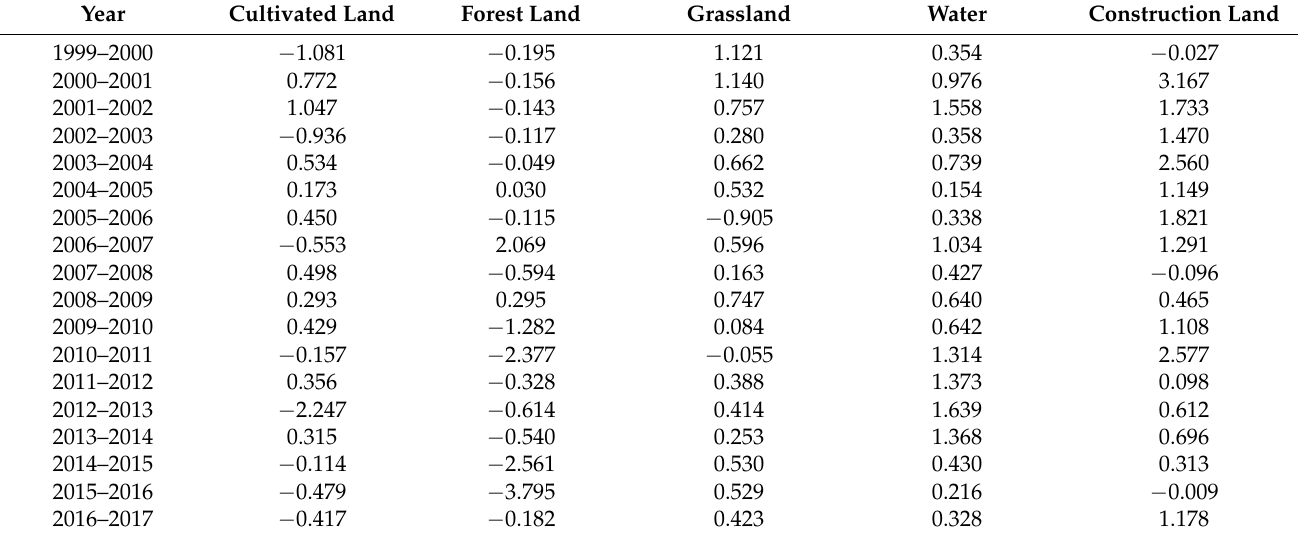
Table 3. The decoupling index of different land capital use and GDP